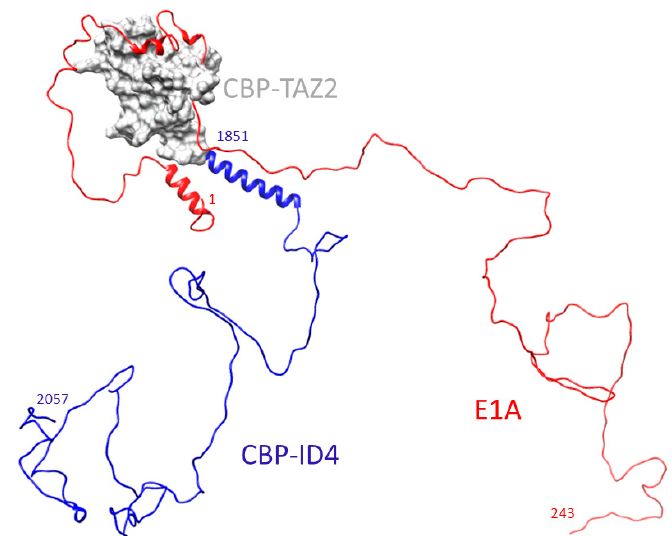
Figure 9. Cartoon describing one of the possible modes of interaction of E1A12S with the CBP-region comprising the TAZ2 domain and ID4. The structure of TAZ2 (grey surface) and of the fragment 53–91 of E1A is the first model of the PDB ID 2KJE entry (solution structure). The fragments 1–52 and 92–243 of E1A as well as the CBP-ID4 fragment were selected among the conformers of Flexible Meccano generated ensembles.